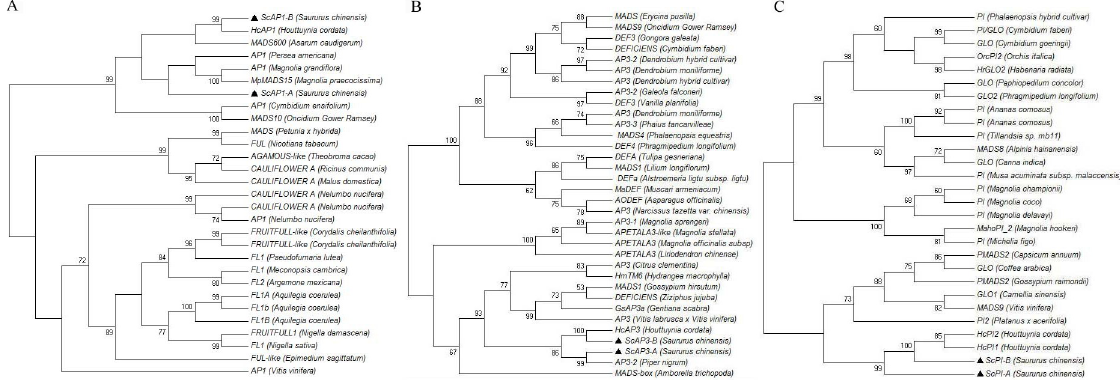
Fig 8. Bootstrap consensus tree of Minimum Evolution method analysis of the putative A-class and B-class MADS-box transcription factors, using 1000 bootstrap iterations. Black triangles represent the A-class and B-class MADS-box genes from S . chinensis in this study and others from GenBank that were included in the